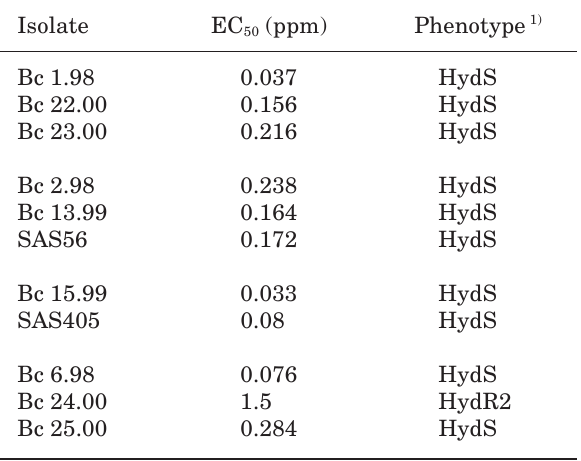
Table 3. EC and phenotypes of Botrytis cinerea detect- 50 ed in Tunisia.